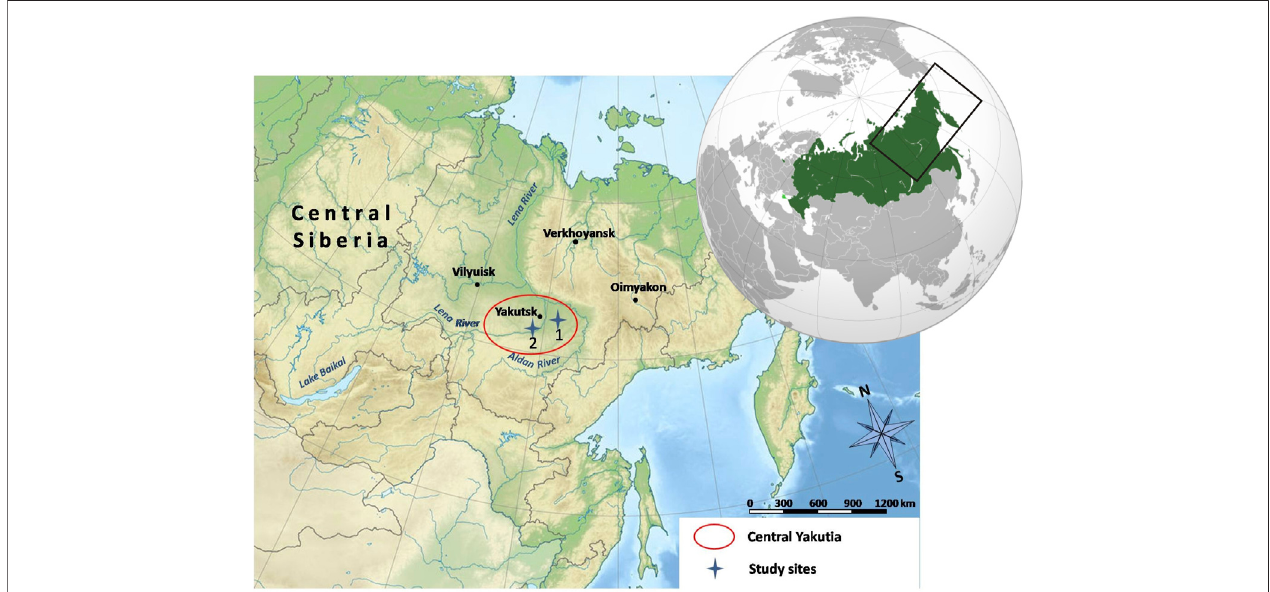
FIGURE 1 | Study area. Key sites: (1) Churapcha and (2) Tabaga.